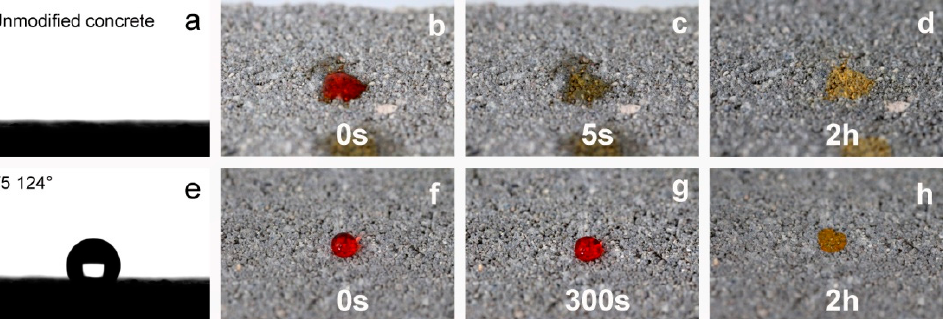
Figure 6. The WCA on the unmodified concrete surface ( a ) and with coating F5 ( e ); images of a water droplet on the unmodified surface ( b – d ) and with coating F5 ( f – h ); directly after deposition and after evaporation. Table 2. Water contact angle (WCA) values of concrete without and with OPTES treatment.